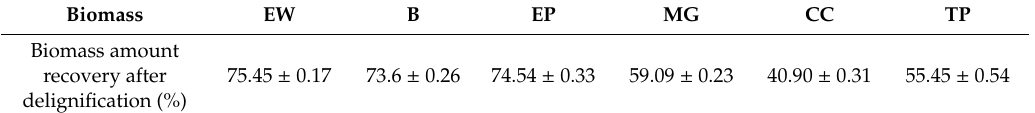
Table 2. Biomass amount recovery after the MEA pre-treatment for EW, B, EP, MG, CC and